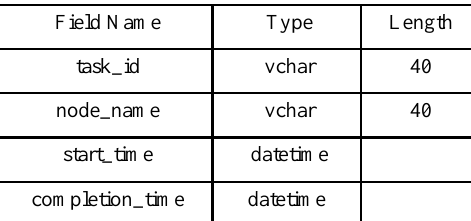
Table 2. The structure of tbl_block_distribution